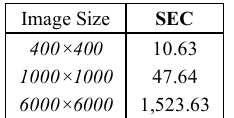
Table 6. Comparative table of the classification time applied to the MRS scene (the results are expressed in